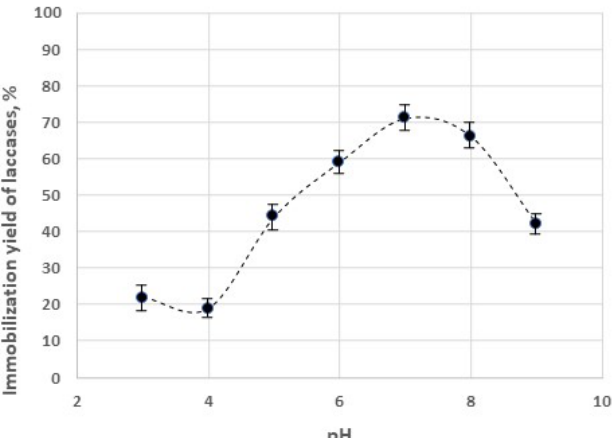
Figure 5. Effect of pH on the immobilization yield of the laccase on chitosan hydrogel. Substrate: 5 mM ABTS.